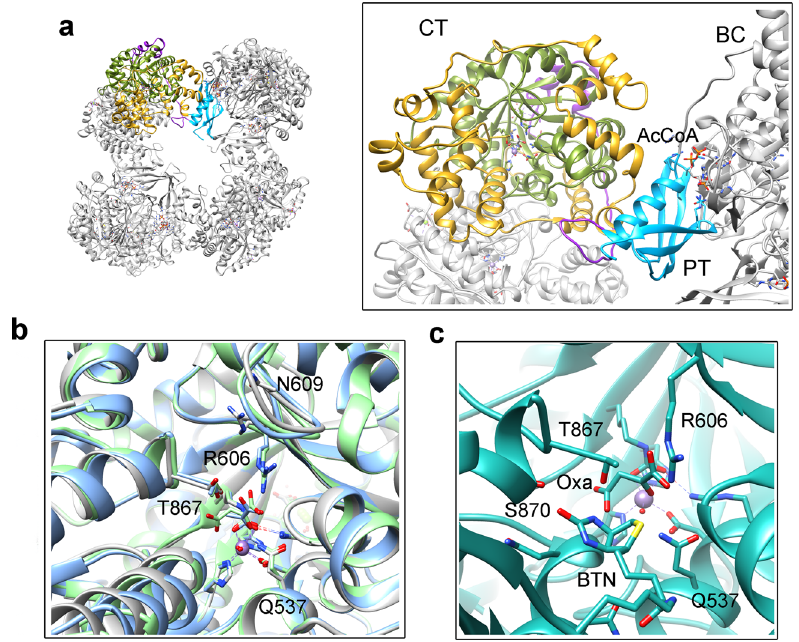
Fig. 6 | Atomic details for CT and PT domains. a Model of tetrameric LlPC and enlargement ofCTandPTdomains from one subunit. The PTdomain is colored in cyan,andattheCTtheTIMbarrelingreen,thefunnelsubdomaininyellowandthe connecting loop in purple. The CT active site is located at the entrance of the TIM barrel and surrounded by the funnel domain. b Overlap of CT empty (gray), CT pyr (blue)andCT oxa (green)models.Thelargestconformationalchangesareproduced in the helix 827-840 (bottom left corner) and the loop 610-617 (top). Arg606